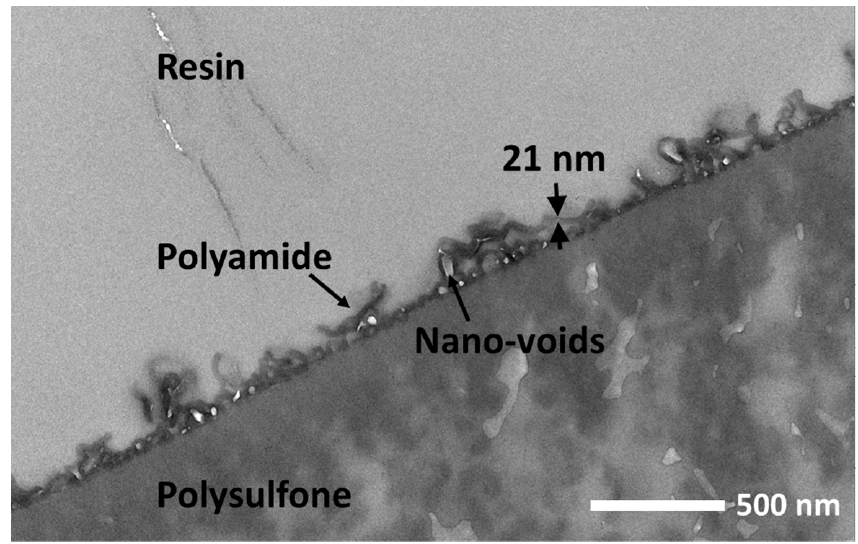
Figure 4. Cross-sectional TEM image of the RFRO membrane; the concentration of PPR is 1.0%.